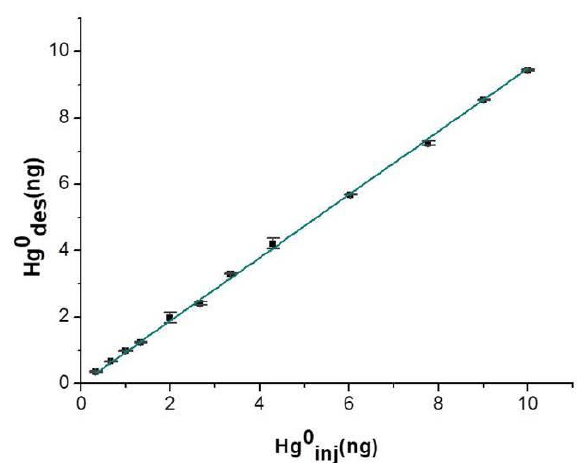
Figure 9. Adsorption curve of mercury vapors (measured as PAS-desorbed mercury) at increasing injected amounts of mercury vapors (ng).